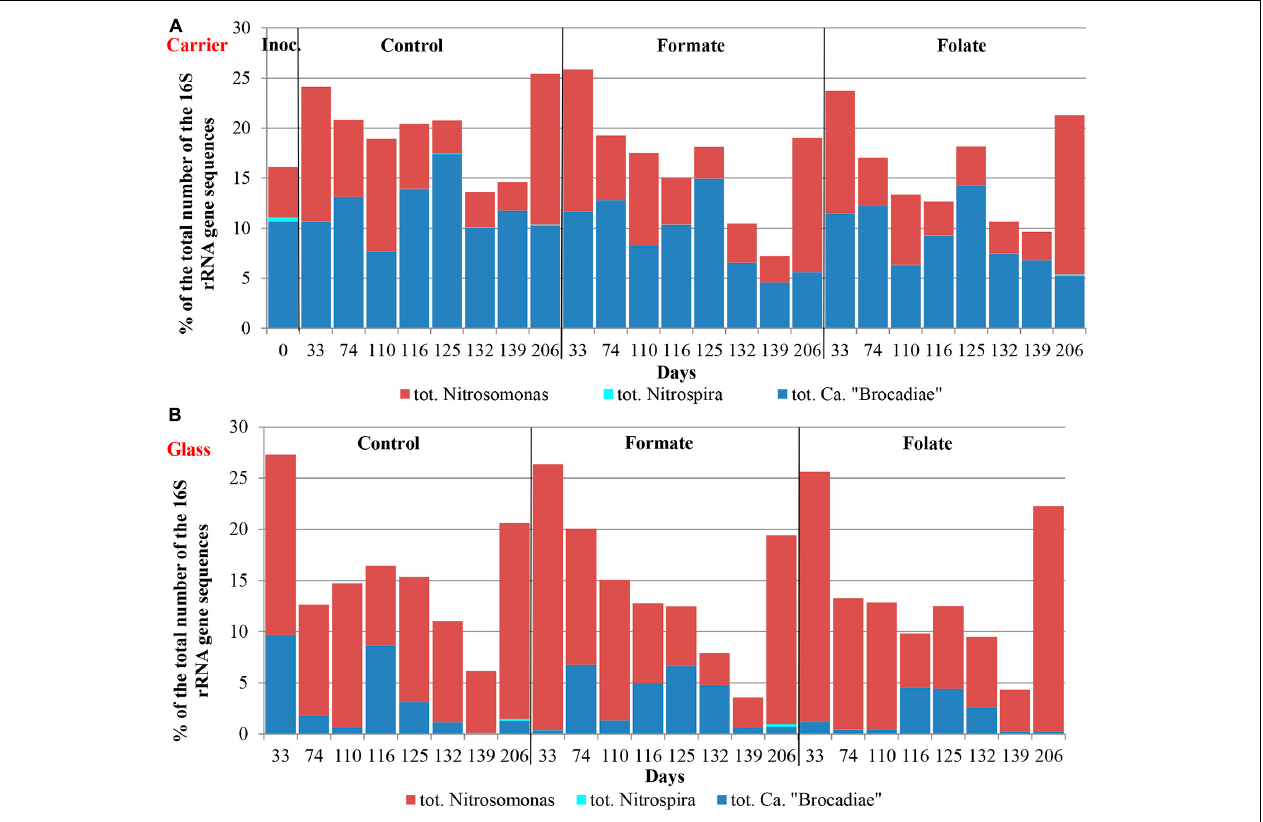
FIGURE 8 | The overall abundance of stage I (genus Nitrosomonas ) and stage II (genus Nitrospira ) nitrifiers and anammox bacteria ( Ca. “Brocadiae” family) in the inoculum and the biomass on the carrier (A) and on the walls of the reactors (glass) (B) before (0–74 days) and after (110–206 days) the additives supplied and the ammonium load increased (the second run of the